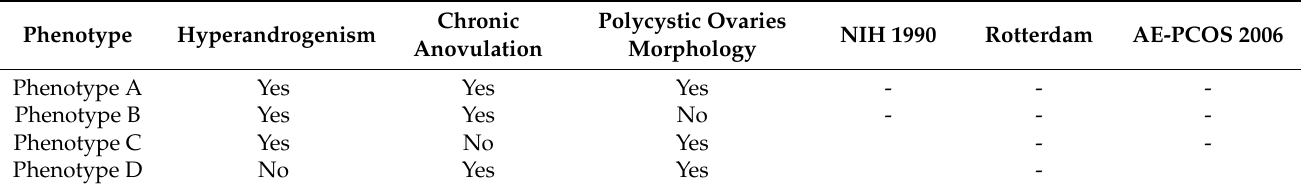
Table 2. Phenotypic Difference Based on Diagnostic Criteria. - explains the difference in phenotype symptoms based on diagnostic